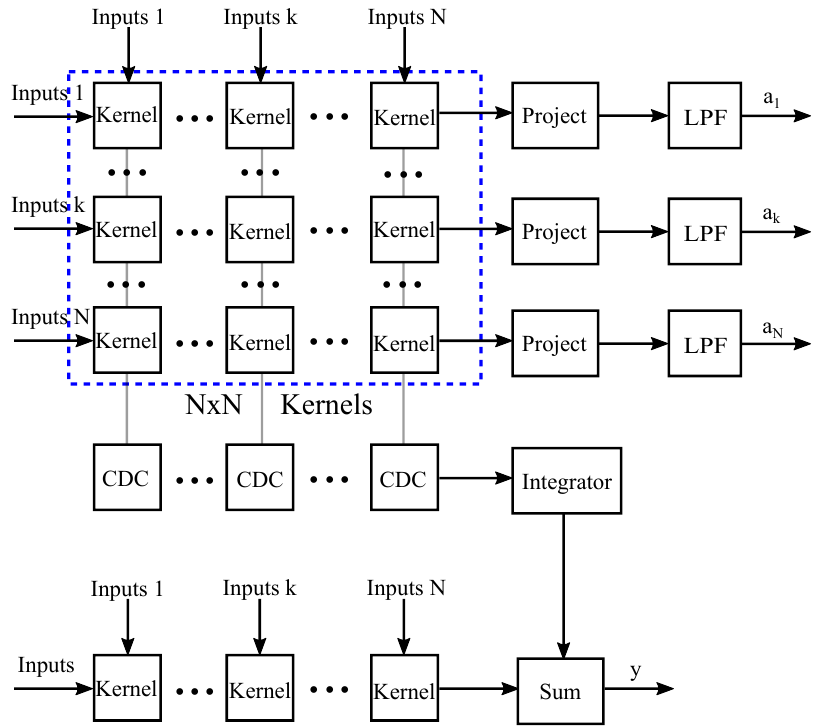
Figure 38. A hardware friendly implementation of the Support Vector Machine algorithm (learning and classification). Table 7. Analog-hardware ML algorithm summary. * tested on LTSpice. ** Estimated. Implementation SVR